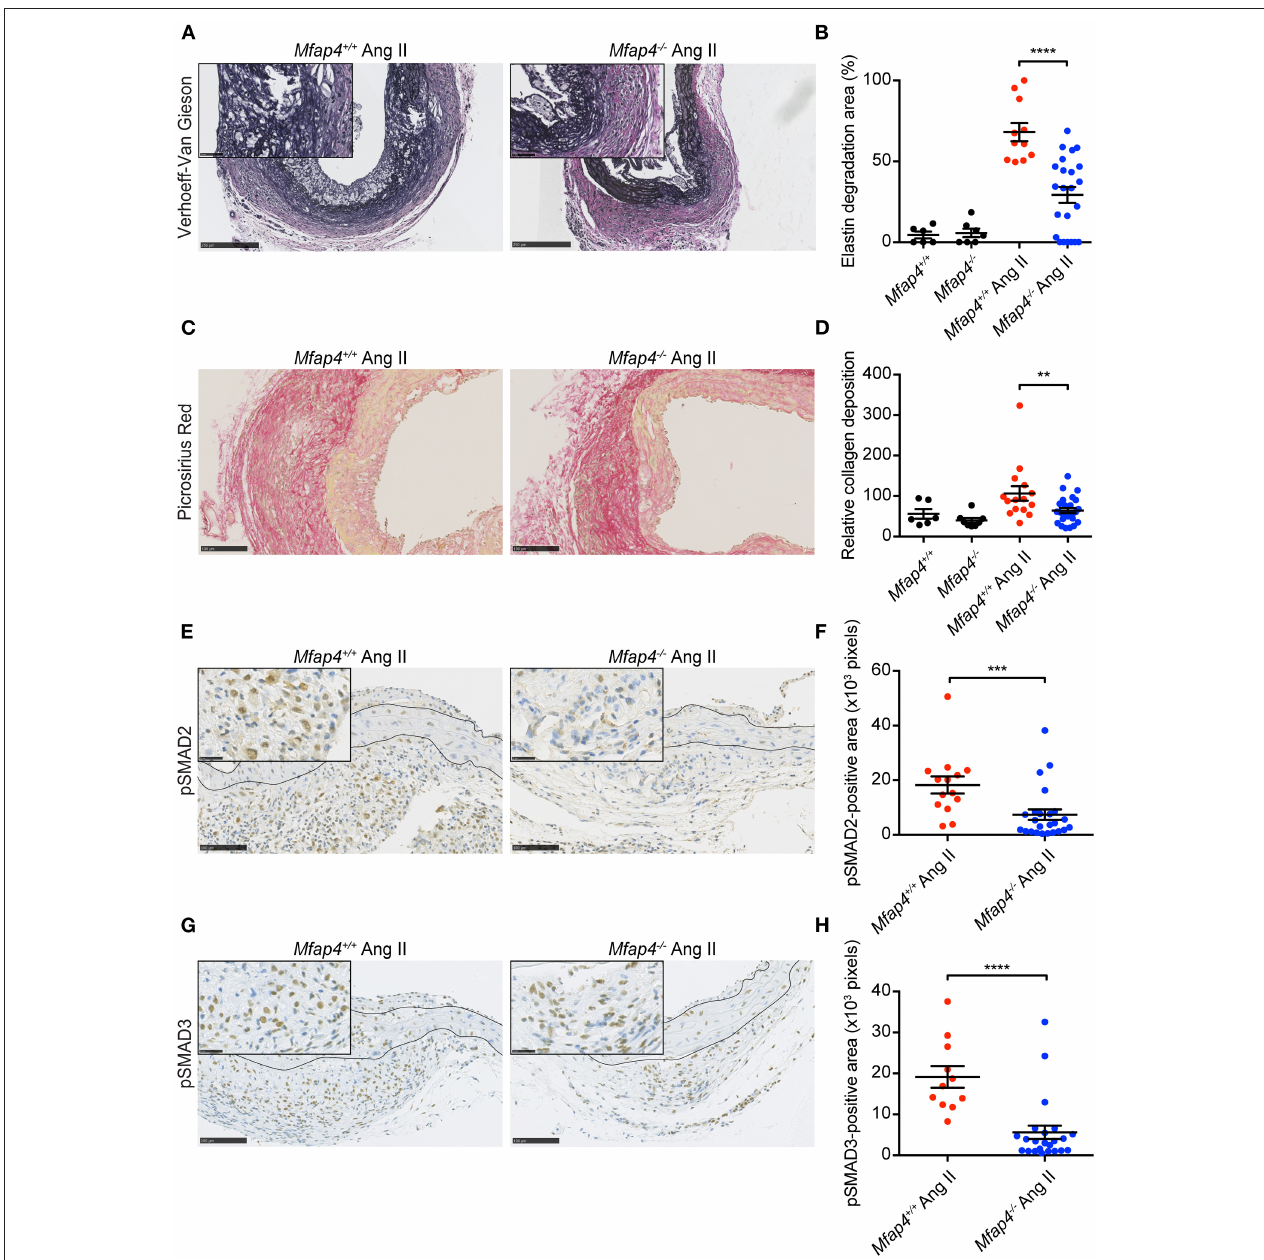
FIGURE 5 | Mfap4 deficiency limits elastic membrane disruption, collagen deposition and fibrotic signaling in Ang II-induced AAAs. Morphometric analysis of (A,B) elastin (Verhoeff-Van Gieson) staining, (C,D) collagen (Picrosirius Red) staining, (E,F) phosphorylated SMAD2 (pSMAD2) staining and (G,H) phosphorylated SMAD3 (pSMAD3) staining of aortic sections of ApoE − / − ( Mfap4 + / + ) and ApoE − / − Mfap4 − / − ( Mfap4 − / − ) mice after 28 days of Ang II infusion. Black lines delineate borders between intimal, medial and adventitial layers. n = 6–8 (saline), 11–26 (Ang II). Representative pictures are shown. Scale bar = 250 µ m/50 µ m (A) , 100 µ m (C) , 100 µ m/25 µ m (E,G) . ** p < 0.01, *** p < 0.001, **** p < 0.0001, analyzed with Mann-Whitney U